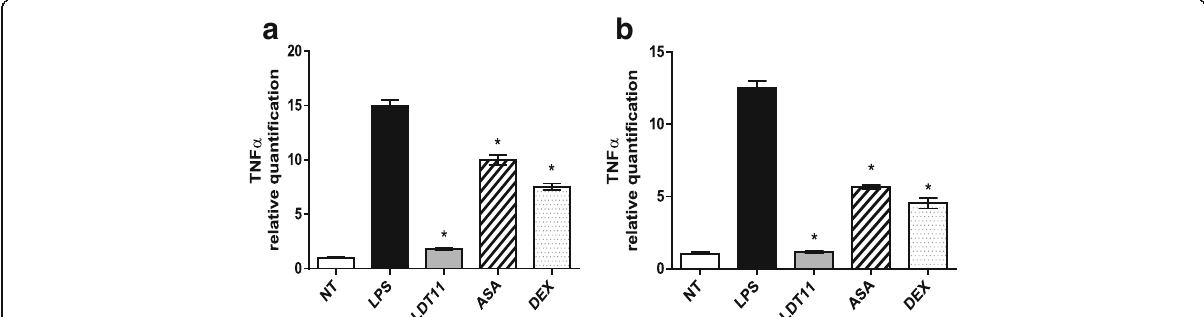
Fig. 5 Determination of the relative amount of TNF- α gene transcripts in RAW 264.7 cell line for the evaluation of inflammatory response at 6 ( a ) and 24 h ( b ) post-stimulus. NT- untreated cells; LPS - LPS-stimulated cells; LDT11 - cells treated with LDT11 and then with LPS; AAS - cells treated with commercial acetylsalicylic acid and then with LPS; DEX - cells treated with the commercial anti-inflammatory Dexamethasone and then with LPS. All data are from at least three independent experiments, * p < 0.05, statistically different compared with cells LPS-stimulated